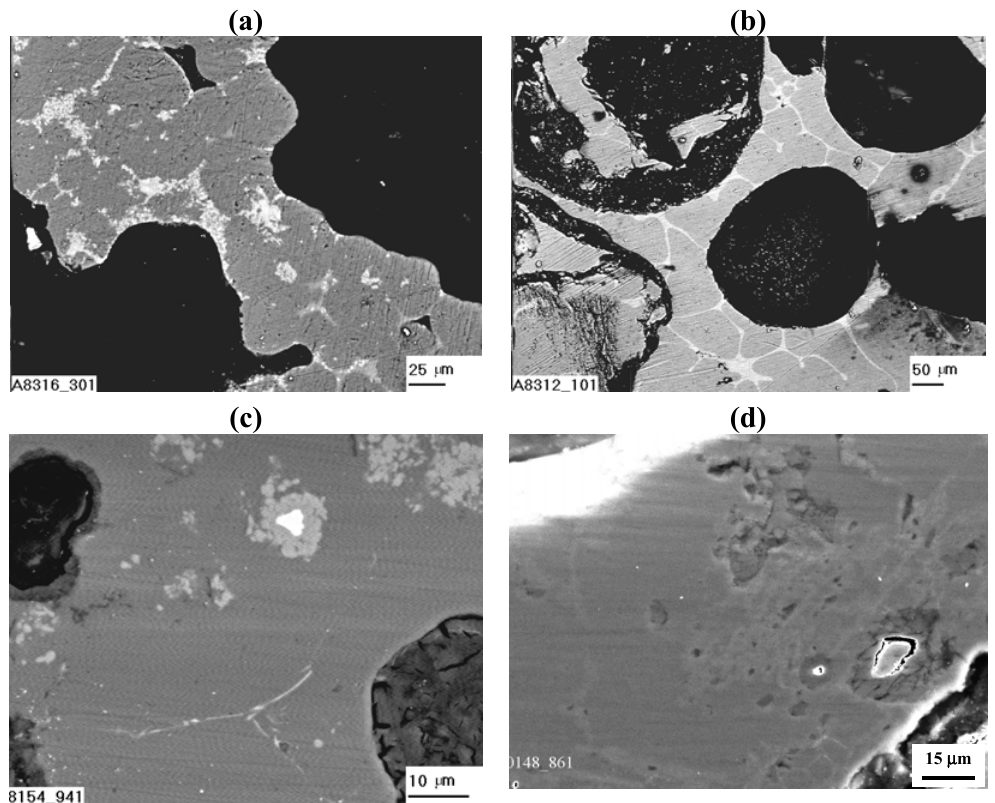
Figure 1. SEM images of the cell walls for Al-foams produced with pure Al by ( a , b ) Alporas melt process and ( c , d ) powder metallurgical technique, all performed either